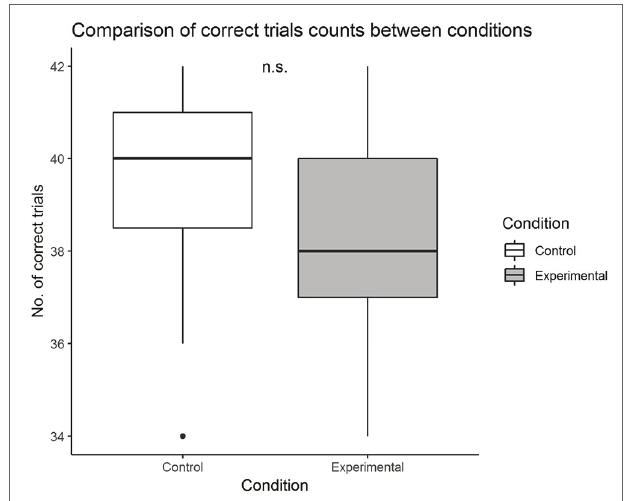
FIGURE 1 | Comparison of number of correct trials between control and experimental groups.